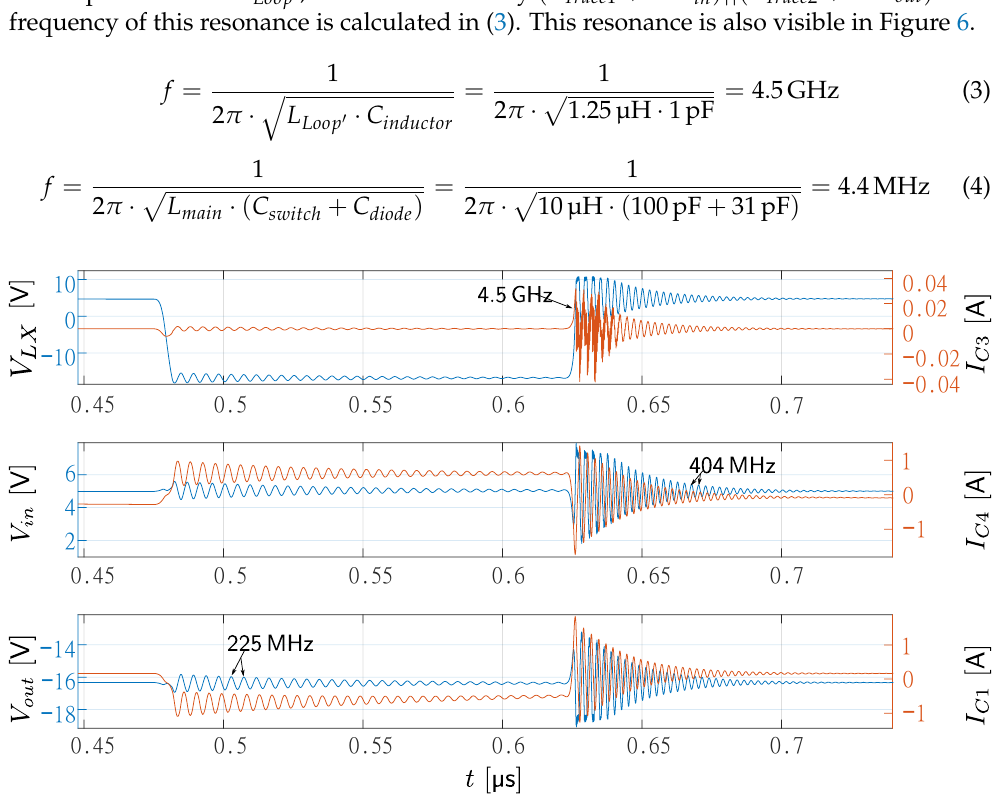
Figure 6. Simulation results during turn-on and turn-off of the converter including parasitic (shown signals are related to Figure